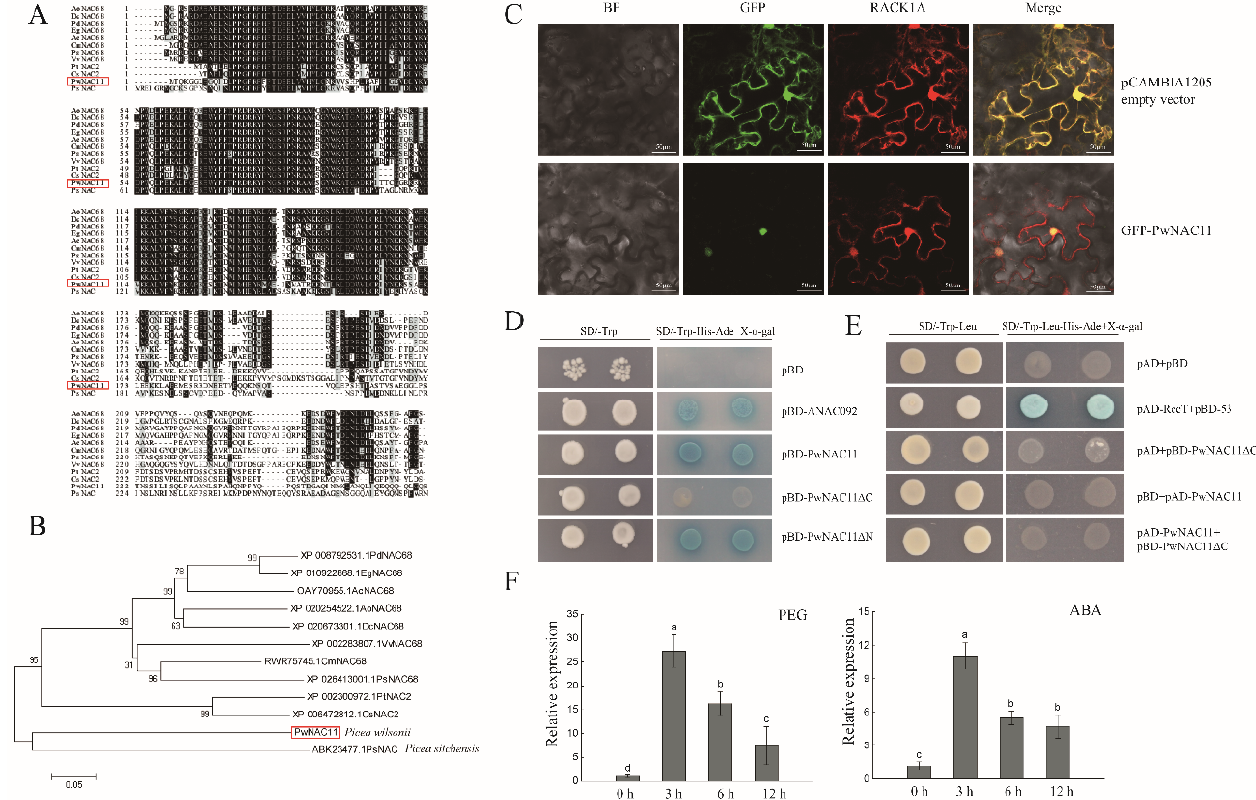
Figure 1. ( A ) Protein multiple sequence alignment of PwNAC11. ( B ) Phylogenetic analysis of PwNAC11. Numbers on each branch represent the confidence of 1000 repetitions. ( C ) Subcellular localization of PwNAC11. RACK1A-RFP is used as a marker gene which locates in nucleus, cytoplasm and cell membrane. The bar in each picture is 10 µ m. ( D ) Yeast trans-acting activity assay. pBD-ANAC092 was used as positive control. pBD-PwNAC11 ∆ N refers to the PwNAC11 protein without N terminal (171–318) and pBD-PwNAC11 ∆ C refers to the PwNAC11 protein without C terminal (1–153). ( E ) Yeast two-hybrid assay for PwNAC11 forming homodimers. pAD-RecT+pBD-53 was used as positive control and pAD + pBD was used for negative control. ( F ) Expression profiles of PwNAC11 in P. wilsonii under drought and ABA treatments. Different letters indicate the significant differences at p < 0.05.